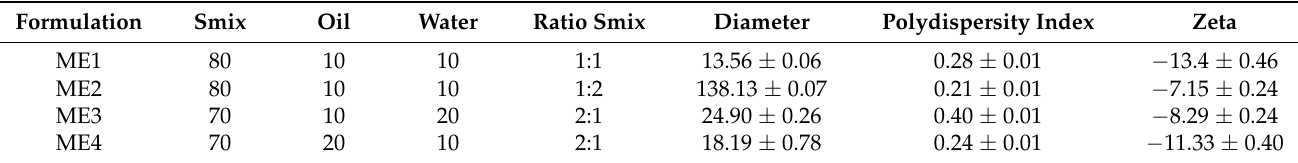
Table 1. The components of each microemulsion, and their properties.